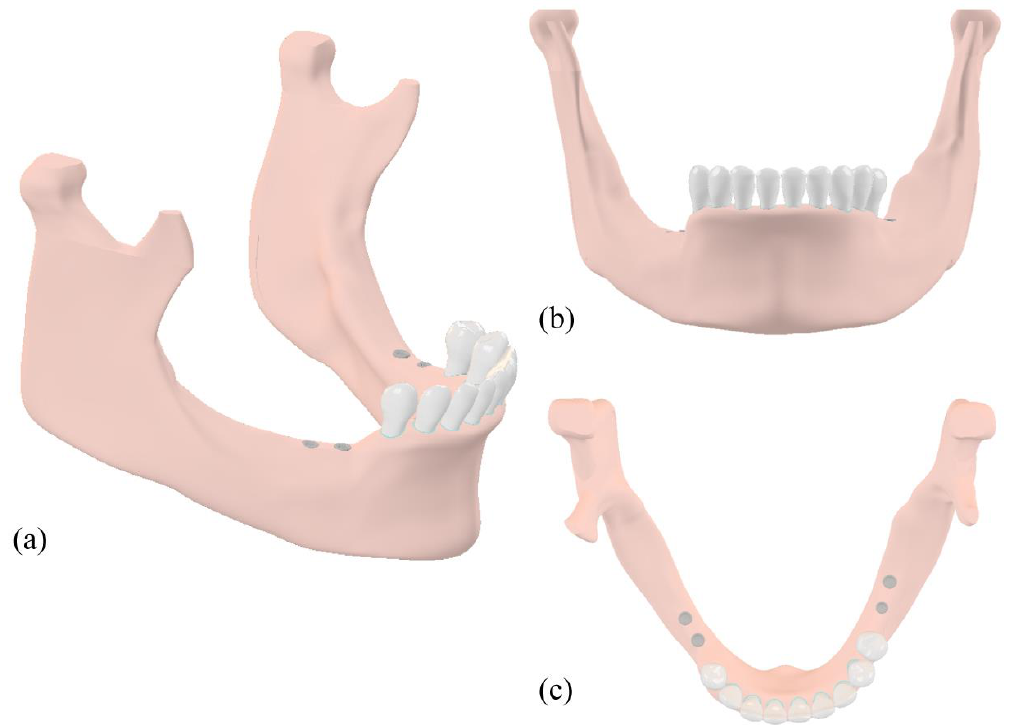
Figure 1. Detailed views of the 3D model of the resorbed and the virtually augmented mandible with implants placed in sites 3.6, 3.7, 4.5, and 4.6, and remaining dentition. ( a ) Perspective view of modeled mandible with bone resorption and bilateral posterior edentation with implants placed. ( b ) Front view of modeled mandible with bone resorption and bilateral posterior edentation with implants placed. ( c ) Top view of modeled mandible with bone resorption and bilateral posterior edentation with implants placed.